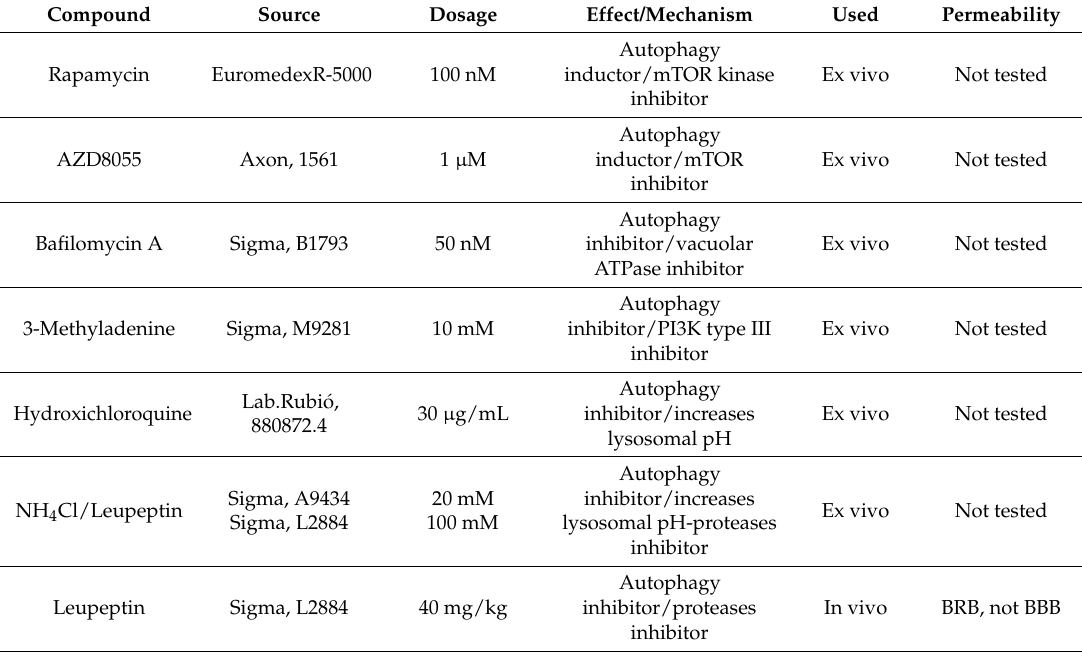
Table 1. Pharmacological modulators of autophagy. Ref; reference, BRB; blood retinal barrier, BBB, blood brain